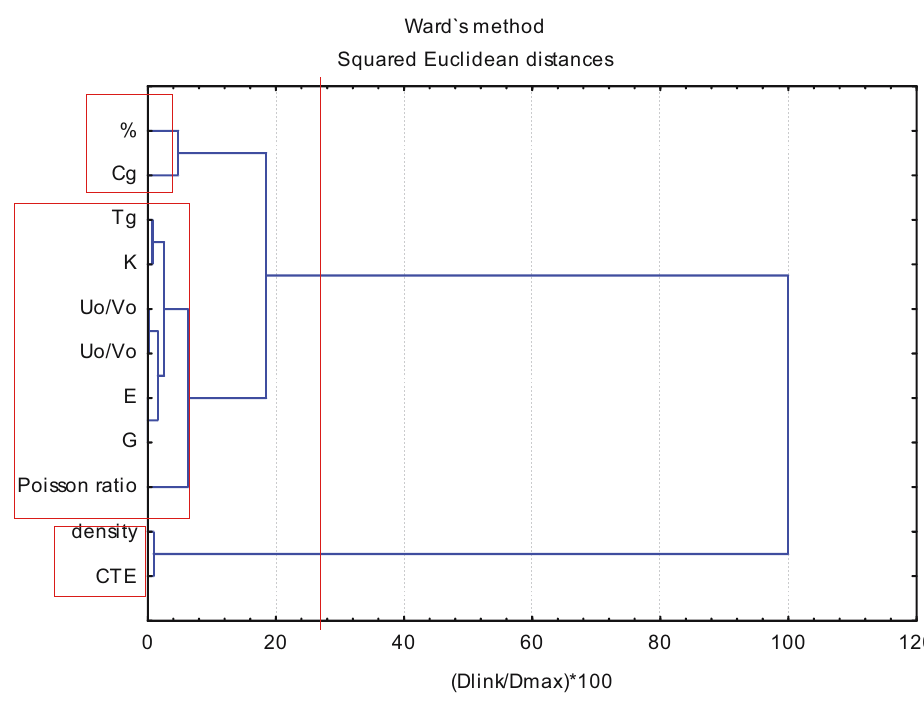
Figure 1: Hierarchical dendrogram for clustering of 11 physicochemical parameters.